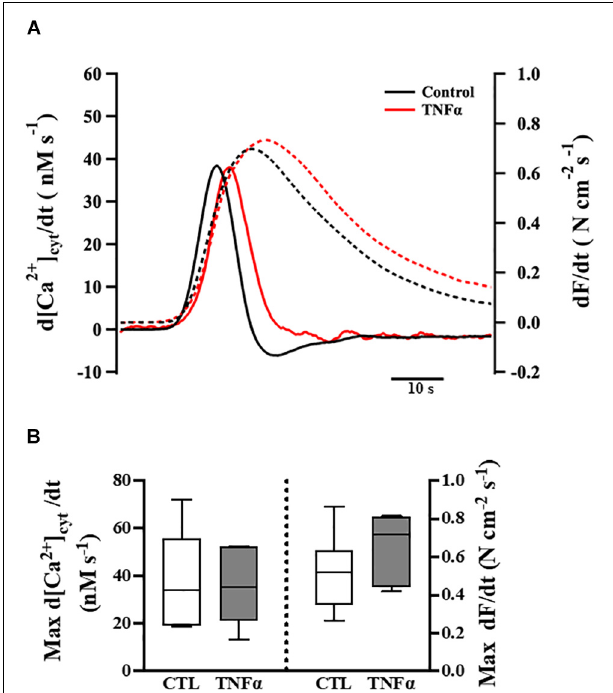
FIGURE 4 | Tumor necrosis factor α exposure had no significant effects on the rates of rise of both the [Ca 2 + ] cyt and force responses of ASM to ACh stimulation (EC 50 ), compared to controls. Representative tracings to show the first derivatives of [Ca 2 + ] cyt (solid lines) and force (dashed lines) responses to ACh stimulation (EC 50 ) (A) . The maximum d[Ca 2 + ] cyt /dt and maximum d Force/ d t at ACh concentration (EC 50 ) are summarized as medians and interquartile range (IQR) (B) . A one-way repeated measure ANOVA was used to analyze results; p > 0.05, n = 6 (number of